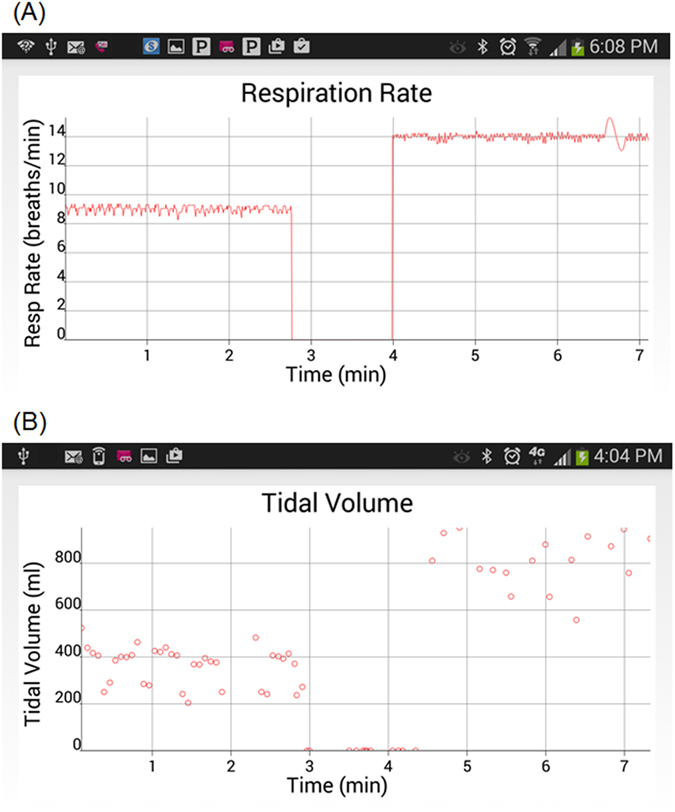
Assessment of apnea.(A) Estimation of the respiration rate (RR) during an apneic event. The RR was changed from 9 breaths/min to 0 breaths/min (ventilator-off) to 14 breaths/min, and the tidal volume (TV) was changed from 760 ml to 0 ml (ventilator-off) to 300 ml. (B) Estimation of the TV during an apneic event. The TV was 250 and 690 ml, and the RR was 14 and 6 breaths/min, before and after the apneic event, respectively. The apnea period occurs from 2 min and 53 sec to 4 min and 43 sec.